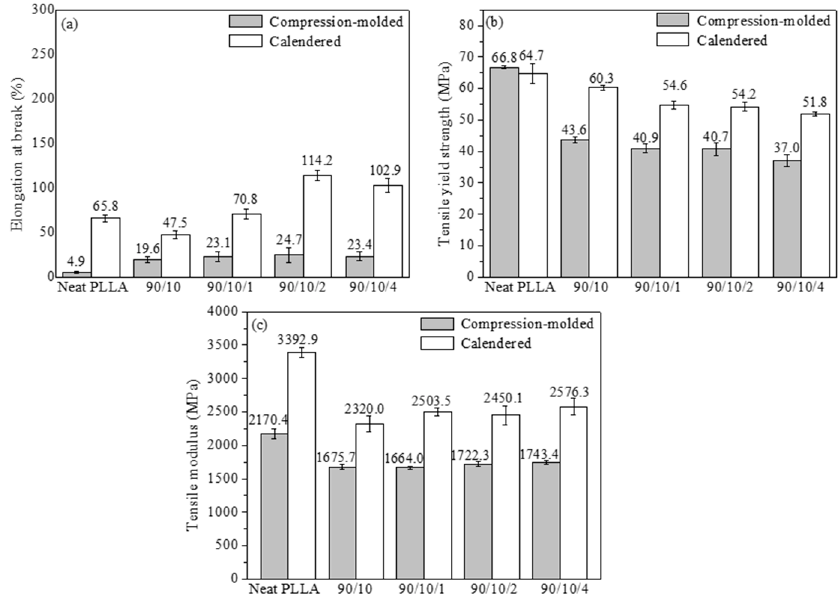
Figure 13. ( a ) elongation at break; ( b ) tensile yield strength; and ( c ) tensile modulus of annealed PLLA and PLLA/EPDM/OMMT (90/10/x) samples prepared by compression-molding and calendering.